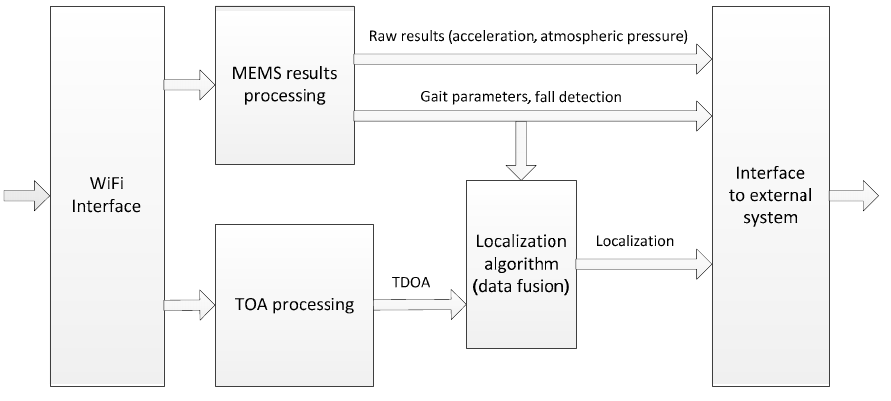
Figure 7. Data processing in the system controller.